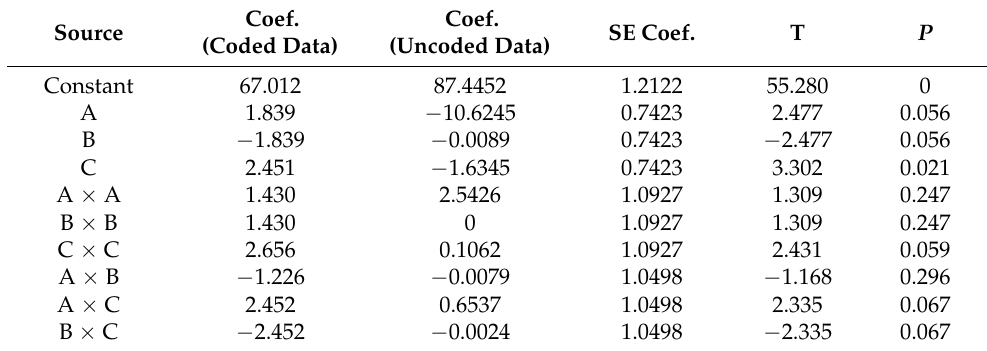
Table 8. ANOVA table of the resistance to water penetration (Schmerber) of the treated fabric for the different parameters (S = 2.1; R 2 = 89.7%). Coef. Coef. SE Coef. T P Source (Coded Data) (Uncoded Data) Constant 67.012